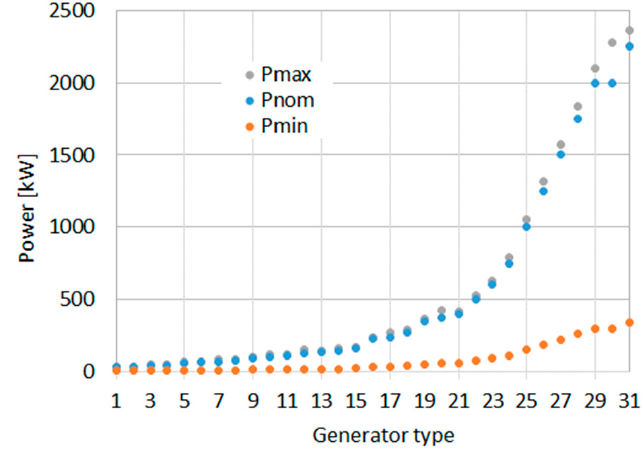
Figure 7. Power nominal, min, max.